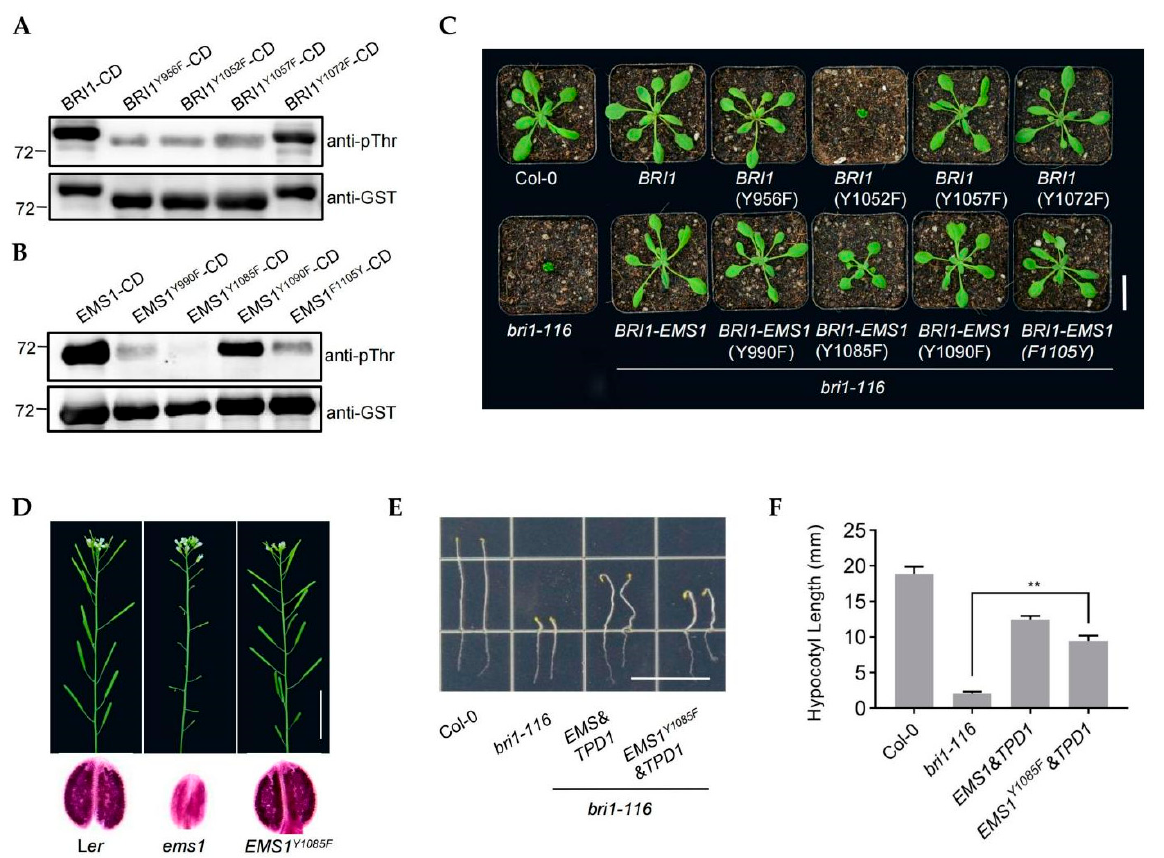
Figure 4. Effects of mutations Tyr residues on EMS1 and BRI1. ( A ) In vitro assay of the kinase activity of recombinant proteins BRI1-CD, BRI1 Y956F -CD, BRI1 Y1052F -CD, BRI1 Y1057F -CD, and BRI1 Y1072F -CD. Phosphorylation levels were analyzed by pThr/Tyr antibody. GST served as the loading control. ( B ) In vitro assay of the kinase activity of EMS1-CD, EMS1 Y990F -CD, EMS1 Y1085F -CD, EMS1 Y1090F -CD, and EMS1 F1105Y -CD. Phosphorylation levels were detected by pThr antibody. GST as the loading control. ( C ) Phenotypes of 4-week-old transgenic plants with single-site mutation in bri1-116 mutant, Scale bar, 2.0 cm. ( D ) Primary inflorescences ( top ) and Alexander staining of pollen grains in mature anthers (bottom) showing the fertility phenotype of EMS1 Y1085F transgenic plant in ems1 background. ( E , F ) Hypocotyl phenotype of EMS1&TPD1 / bri1-116 and EMS1 Y1085F &TPD1 / bri1-116 transgenic seedlings after grown for 7 days in the dark. Scale bar, 1.5 cm. Measurements of hypocotyl length are displayed as means ± SD, n = 10 seedlings. ** p < 0.001 (two-tailed t -test).